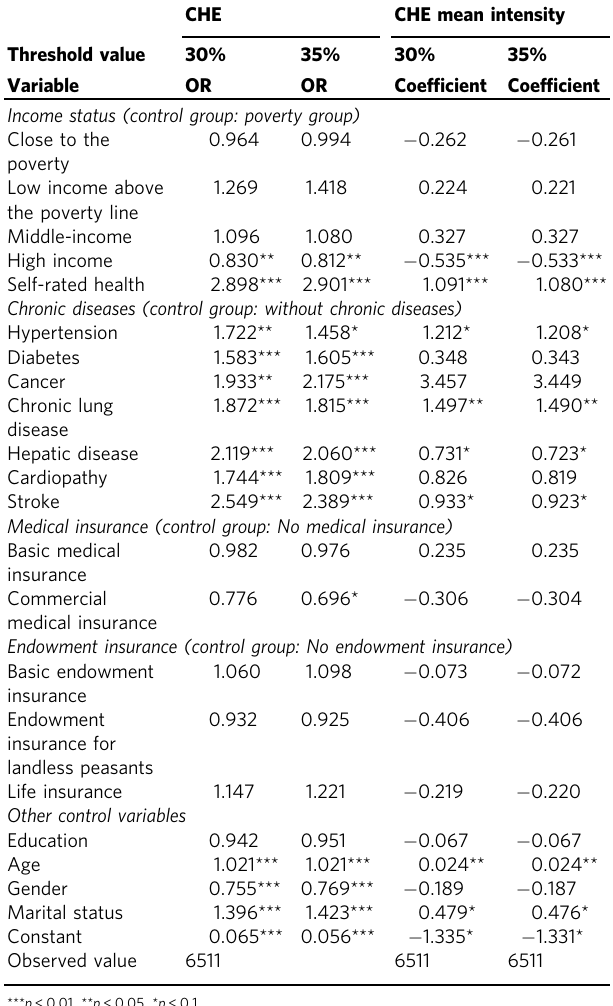
Table 6 Robustness tests for catastrophic health expenditures